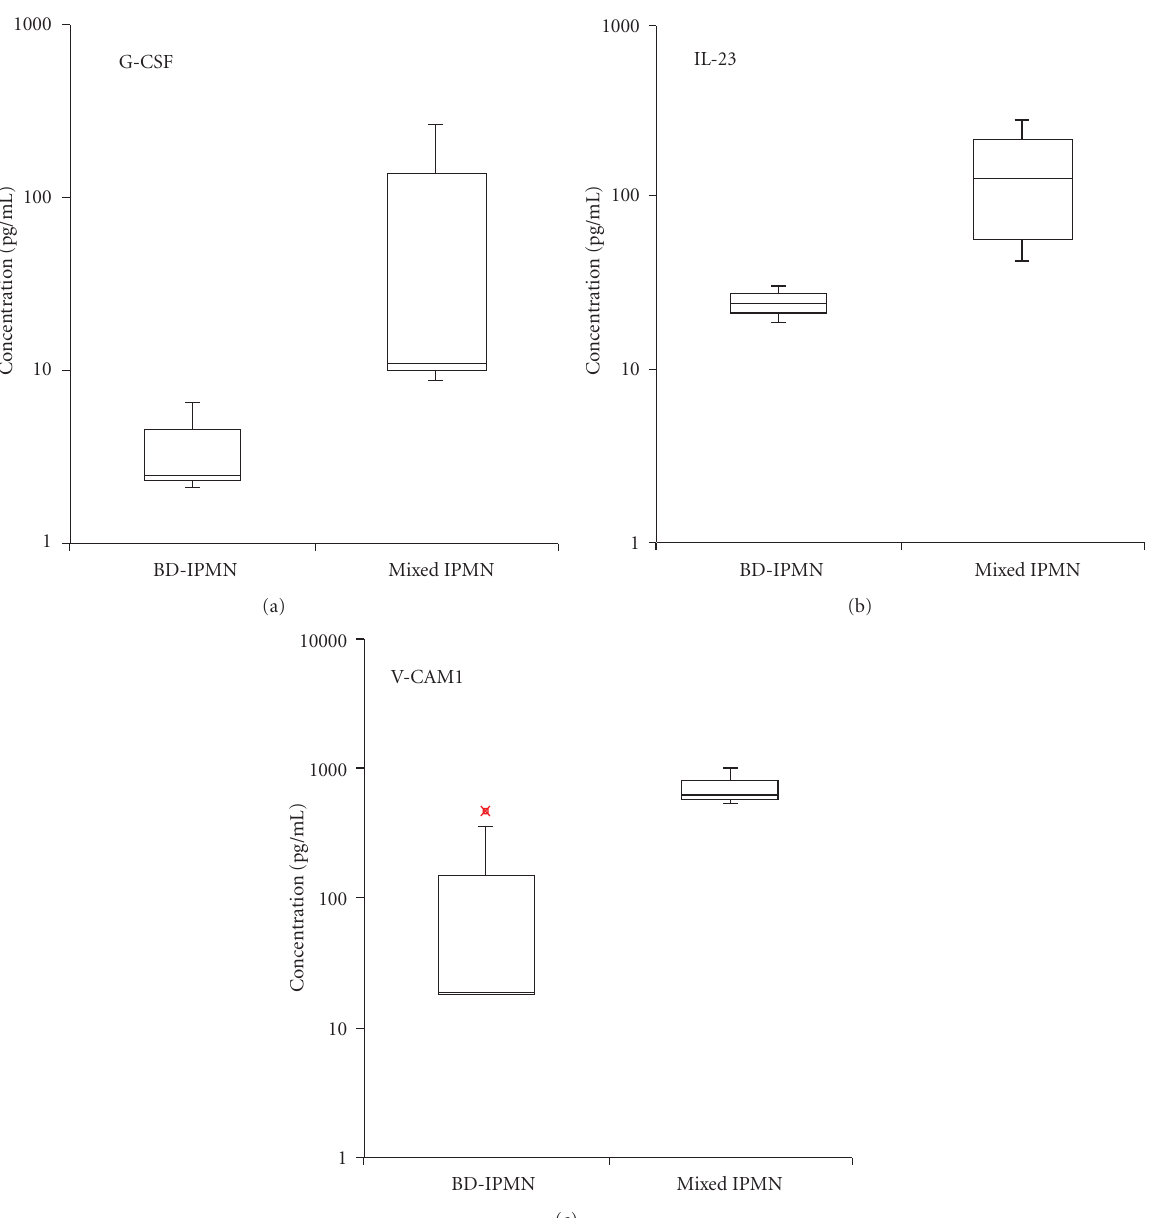
Figure 3: Box and whisker plots of di ff erentially expressed IMPs between BD-IPMN and mixed IPMN. (a) G-CSF, P value < 0.05, (b) IL-23, and (c) VCAM-1, P values < 0.1. Bottom and top edges of box at 25th and 75th percentiles, respectively. Horizontal line within box marks 50th percentile (median). Whiskers extend from box as far as data extend, at most 1.5 interquartile ranges. Outlier represented by